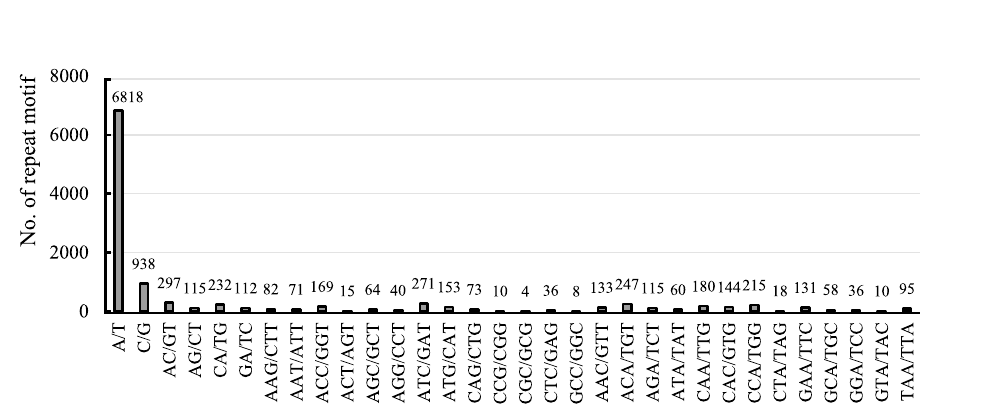
Table 2. Summary of Chrysanthemum SSRs identified based on the full-length transcriptome sequences.